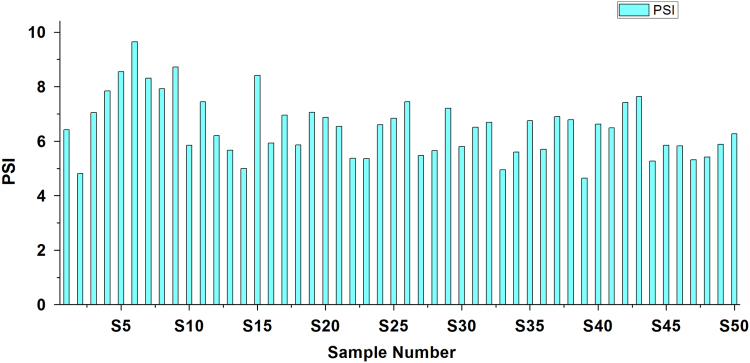
Aggressive index.